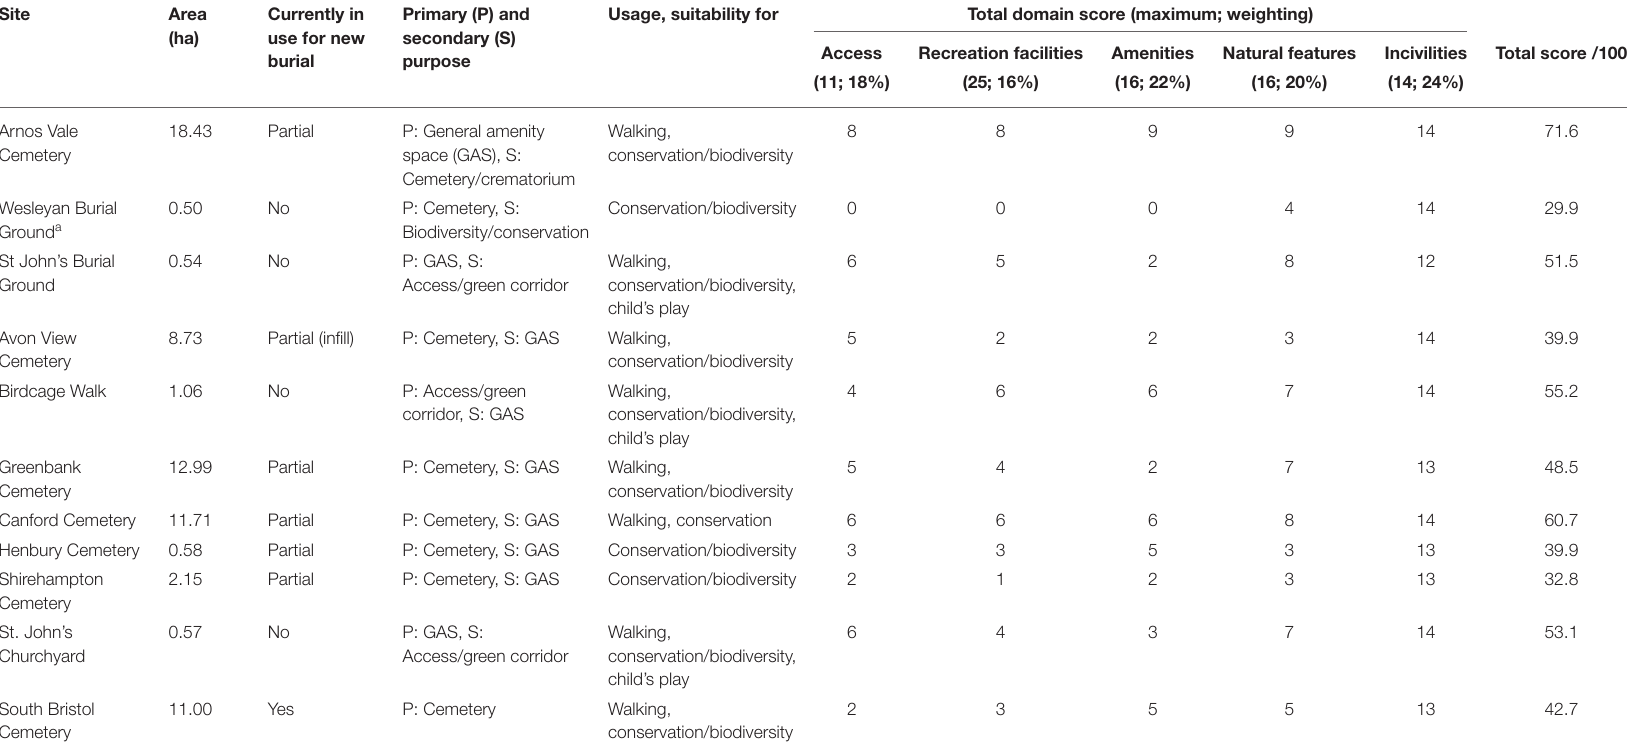
TABLE 5 | Quality of cemeteries as greenspaces in Bristol using the Neighbourhood Green Space Tool (Gidlow et al., 2012).